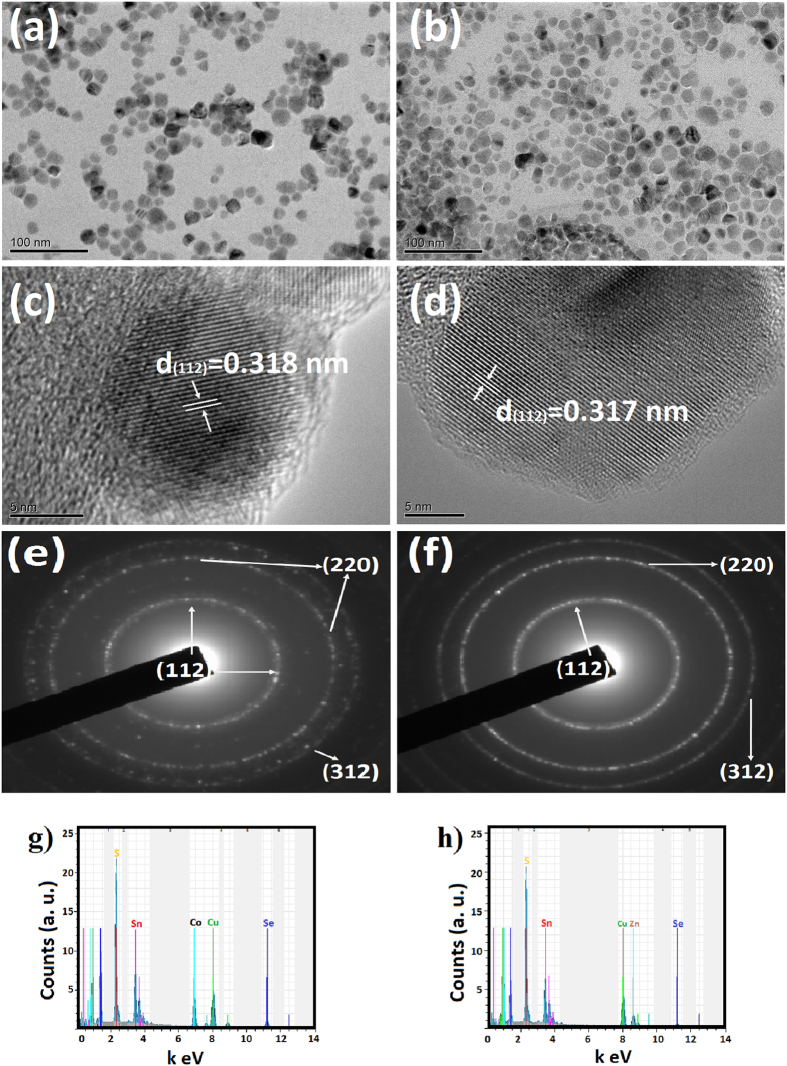
(a,b) TEM images, (c,d) HR-TEM images, (e,f) SAED patterns and (g,h) EDS spectra of Cu2CoSn(SeS)4 and Cu2ZnSn(SeS)4 nanocrystals, respectively.